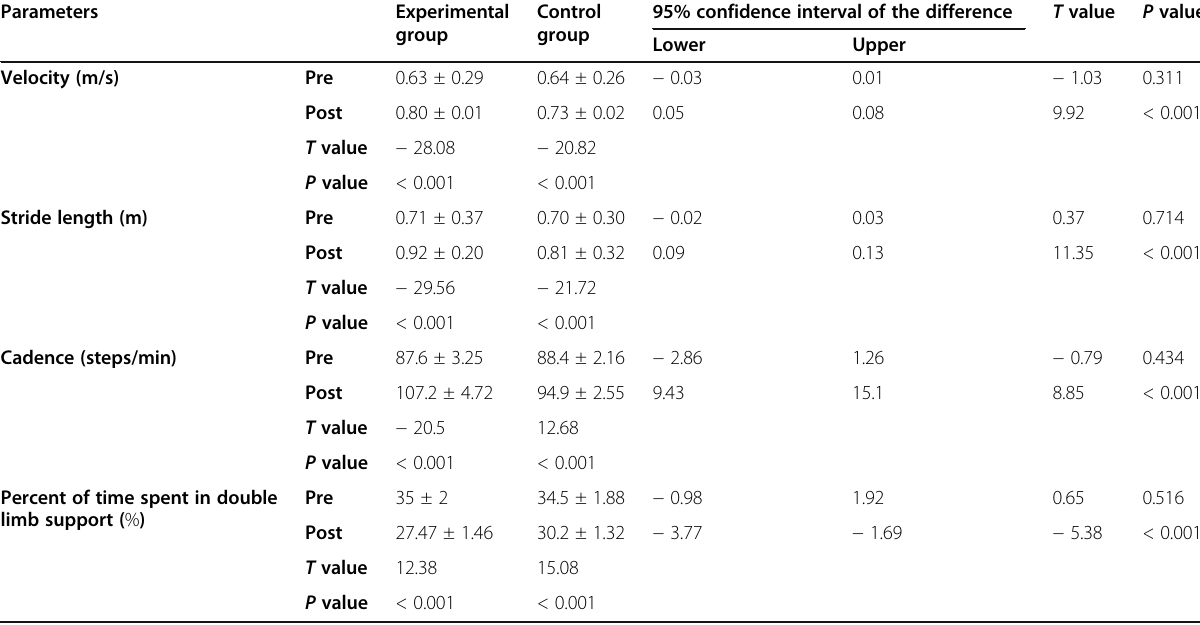
Table 2 Pre and post-treatment mean values of gait parameters within each group and between groups